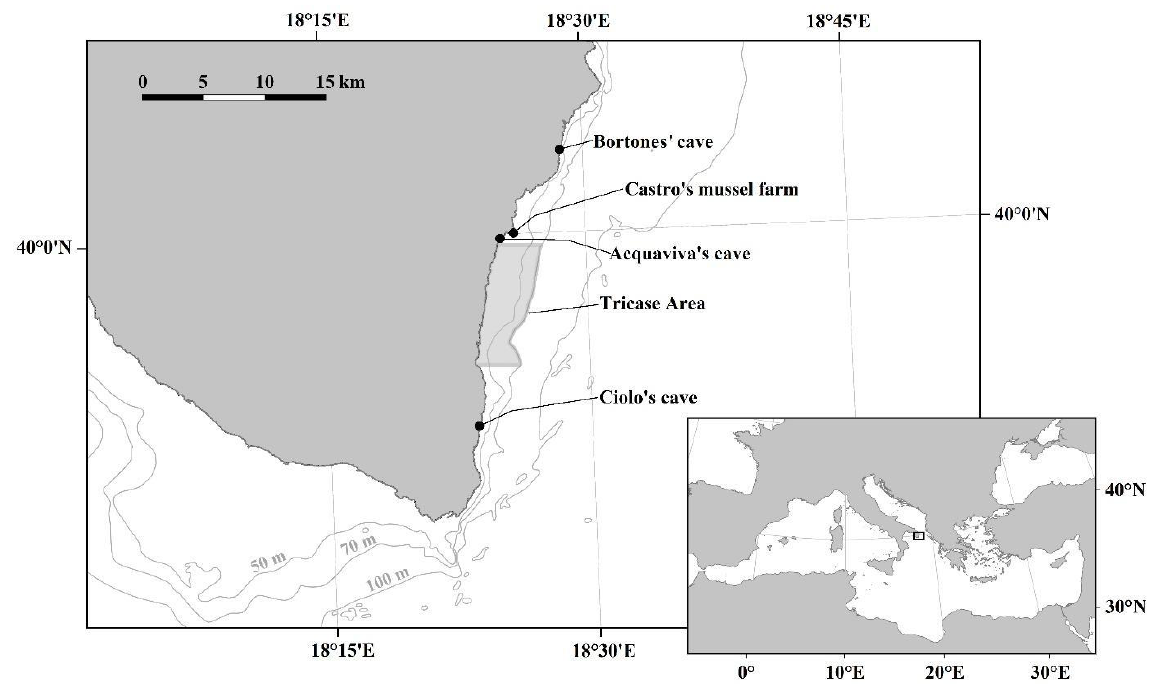
Figure 1. Map of the southeastern tip of the Salento Peninsula (Italy). The Tricase Area is highlighted in gray; black dots indicate the additional study sites. In the bottom right corner: the location of the study area in the Mediterranean Sea. After Micaroni et al. [49].